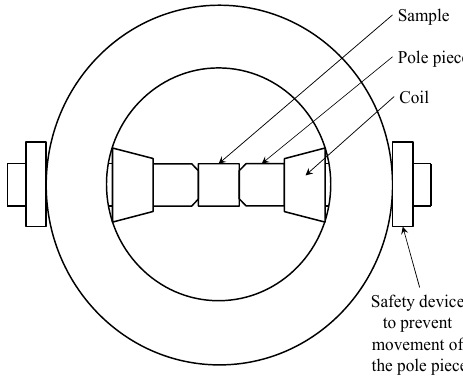
Figure 6. Position of a sample between poles.